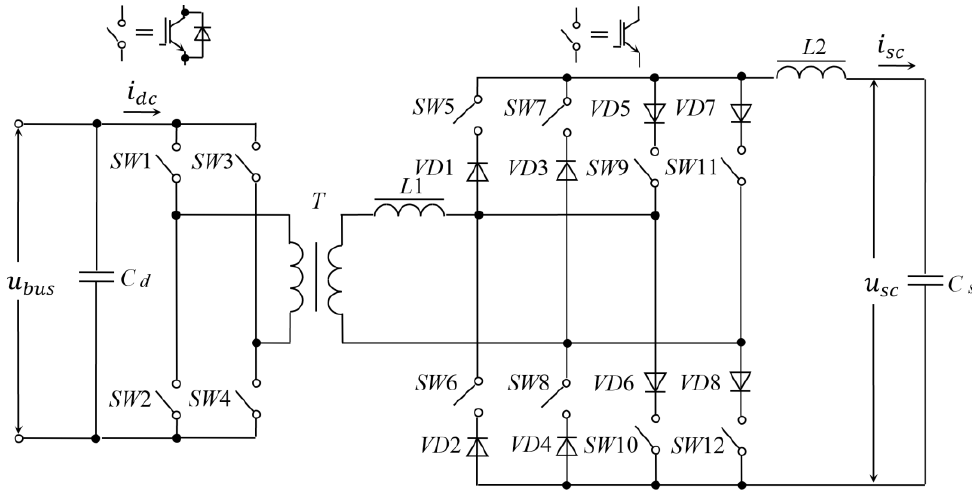
Figure 18. ZVT/ZCS converter